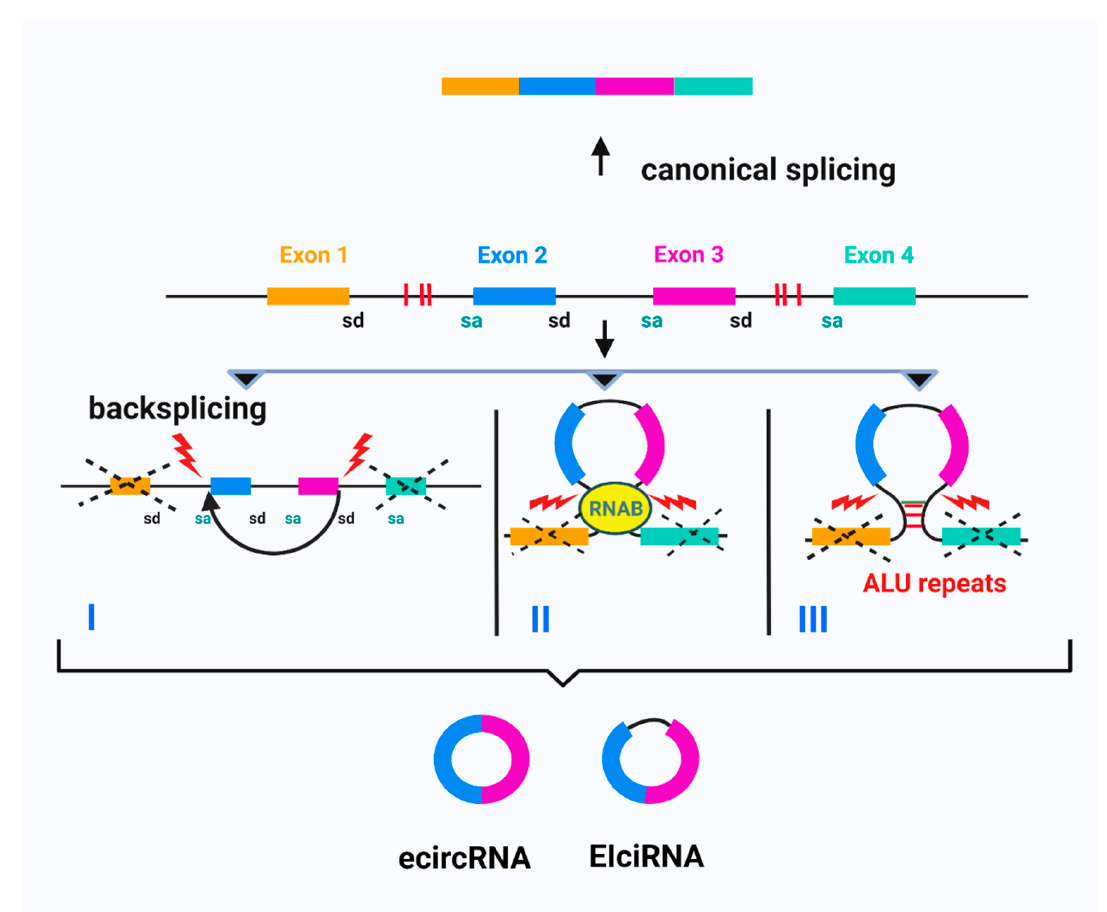
Figure 1. Biogenesis of ecircRNAs and EIciRNAs. I: Back-splicing—the splice donor binds covalently to splice acceptor; II: RNA-binding-protein-driven circularisation; III: Intron-pairing driven circularisation based on intronic ALU repeats. Adapted from “circRNA in Cancer”, by BioRender.com (2021). Retrieved from: https://app.biorender.com/biorender-templates (accessed on 18 November 2021). (sd—splice donor; sa—splice acceptor; RNAB—RNA binding protein; red bars—ALU repeats).